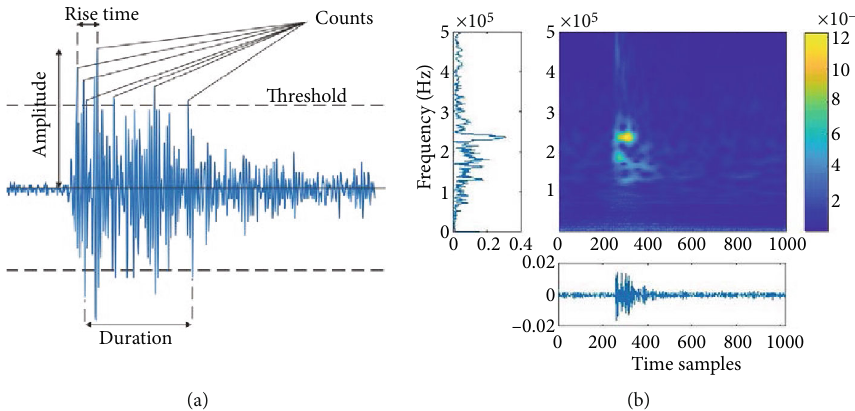
Figure 2: AE signals: (a) a sample AE event; and (b) the time-frequency characteristics of a sample AE